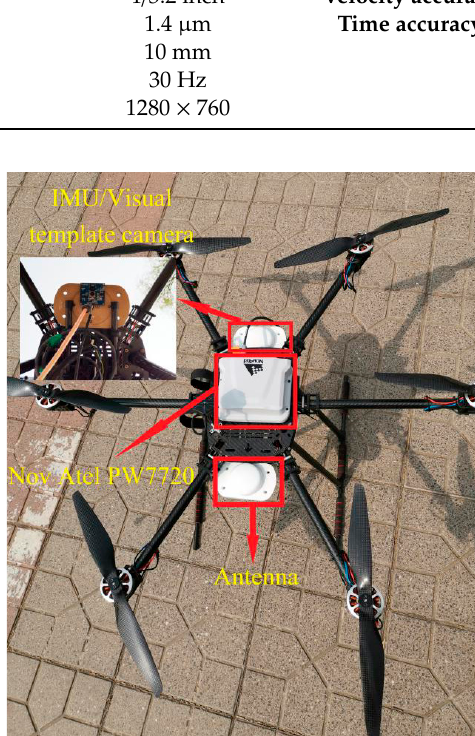
Figure 7. Experimental facilities. Table 2. Parameters of experimental equipment.